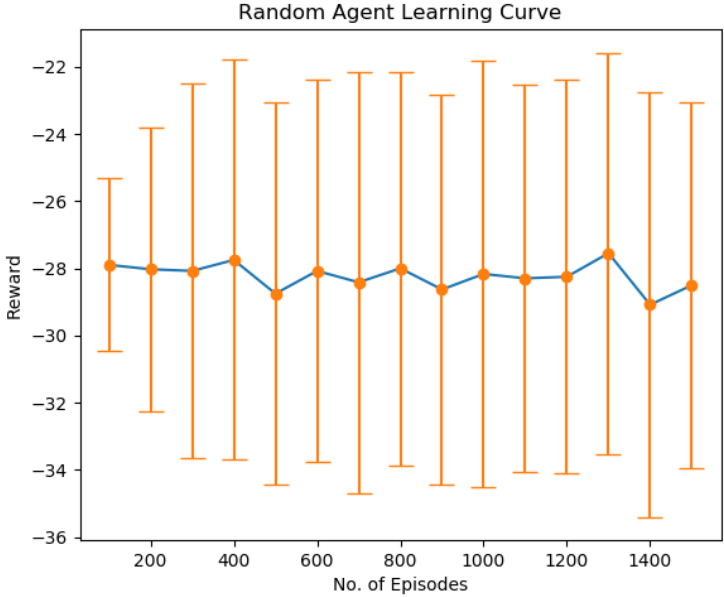
Figure 4. Sumrate performance of Random algorithm.